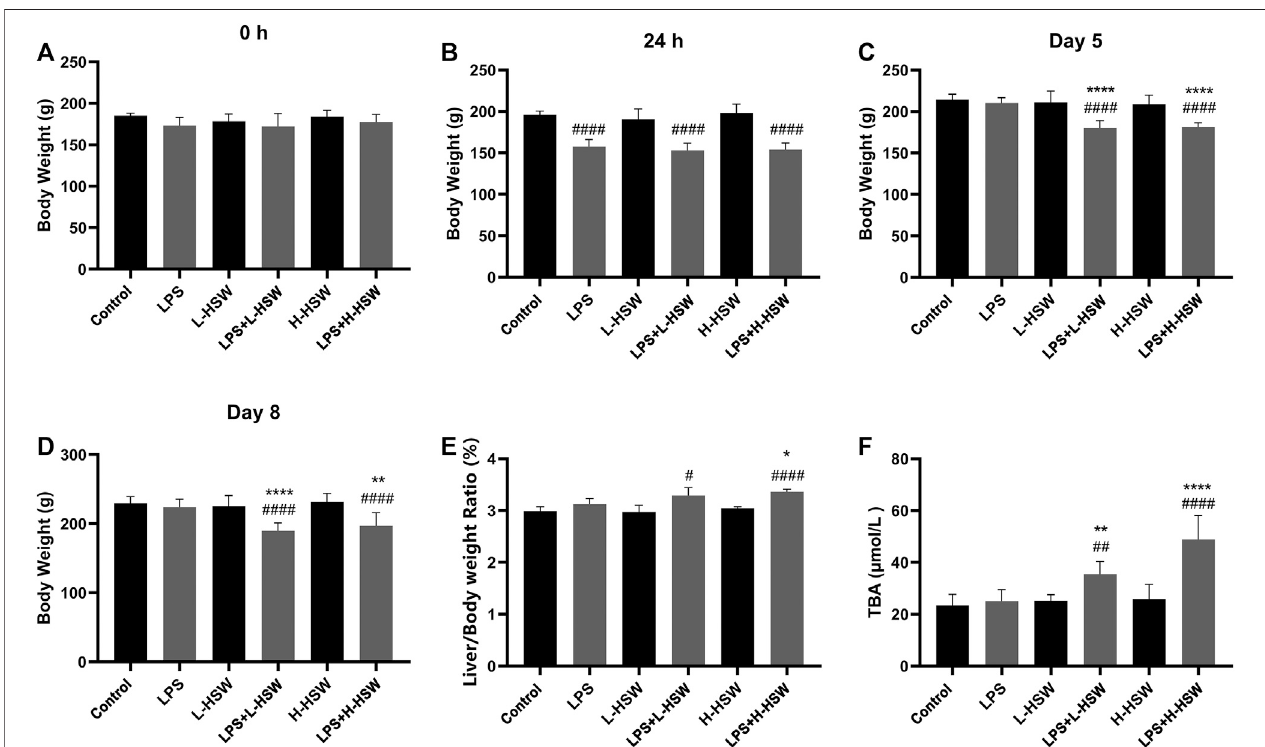
FIGURE 1 | Histograms of body weights, liver/body ratios, and serum TBA levels. Six groups of rats were treated with saline (control), 2 mg/kg dose of LPS (LPS), 2 g/kg/dayHSW(equivalentofrawherb,L-HSW),10 g/kg/dayHSW(equivalentofrawherb,H-HSW),2 mg/kgLPSplus2 g/kg/dayHSW(LPS+L-HSW),and2 mg/kg LPS plus 10 g/kg/day HSW (LPS + H-HSW), respectively. Body weights at 0 h (A) , 24 h (B) , day 5 (C) , and day 8 (D) as well as the liver/body ratio at day 8 (E) were measured; serum TBA levels (F) were determined with corresponding kits. Each bar represents the mean ± standard error ( n (cid:2) 6). # p < 0.05, ## p < 0.01, ### p < 0.001, and #### p < 0.0001 comparing with control group. * p < 0.05, ** p < 0.01, *** p < 0.001, and **** p < 0.0001 comparing with LPS